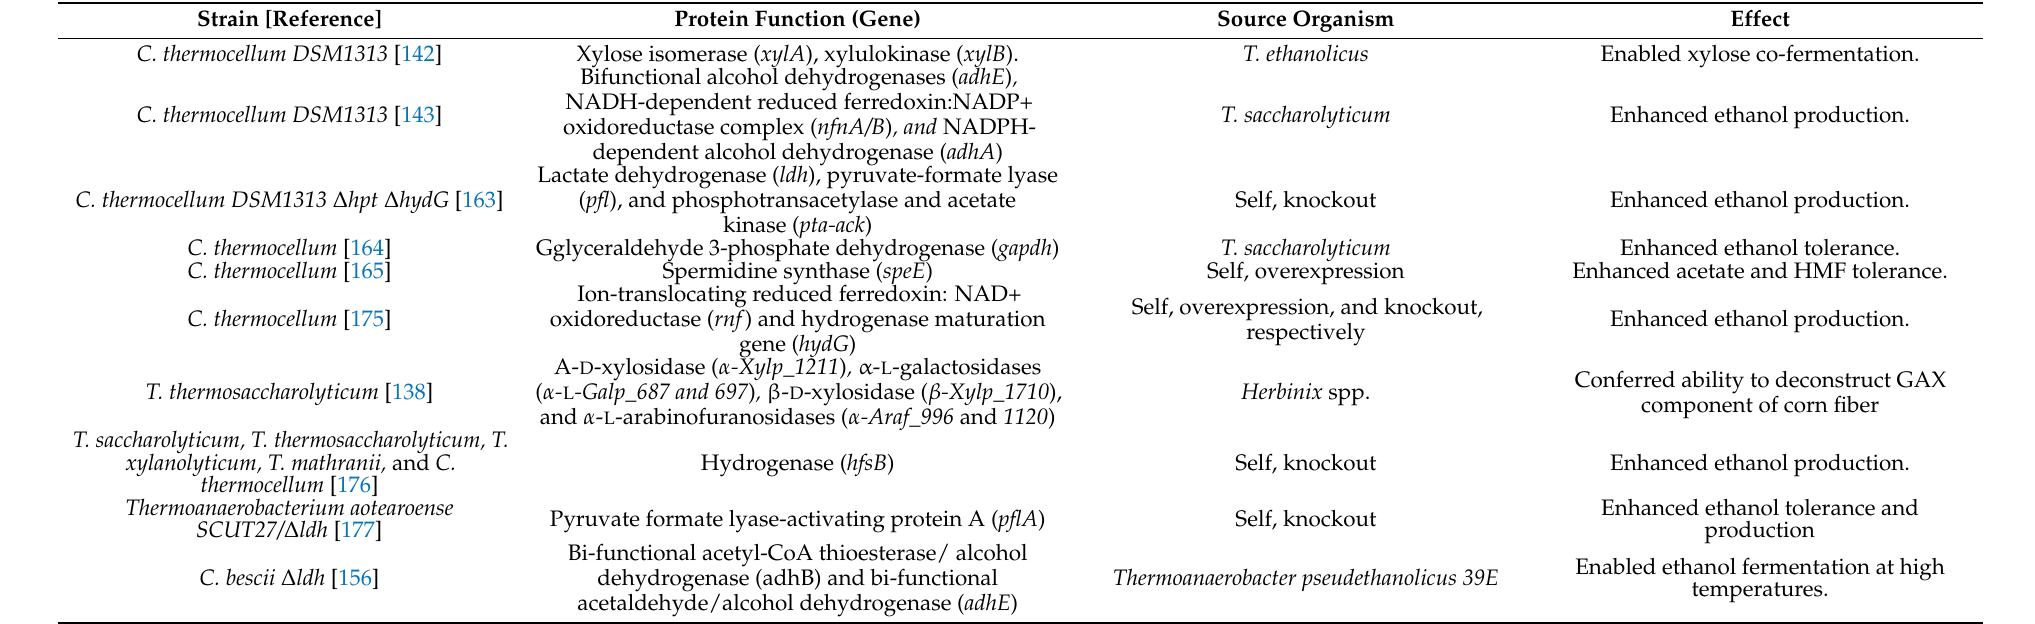
Table 3. Examples of genetically engineered thermophiles to increasing the ethanol